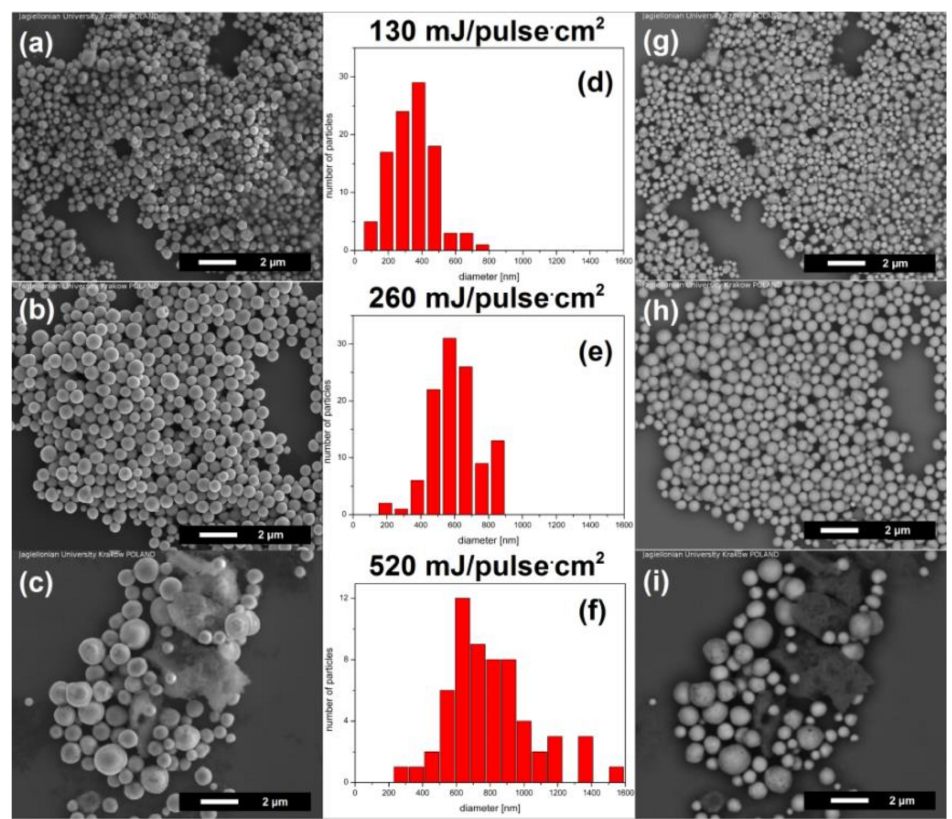
Figure 1. Submicron spherical particles obtained with pulsed laser irradiation of NiO nanoparticles dispersed in ethyl acetate with various laser fluence (laser wavelength of 532 nm, irradiation time—60 min): ( a – c ) SEM (scanning electron microscope) SE (secondary electrons) images (topography contrast); ( d – f ) particle size distribution histograms; ( g – i ) BSE (back scattered electrons) images (atomic number